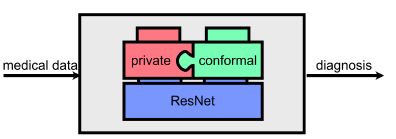
Figure 1: Modular data